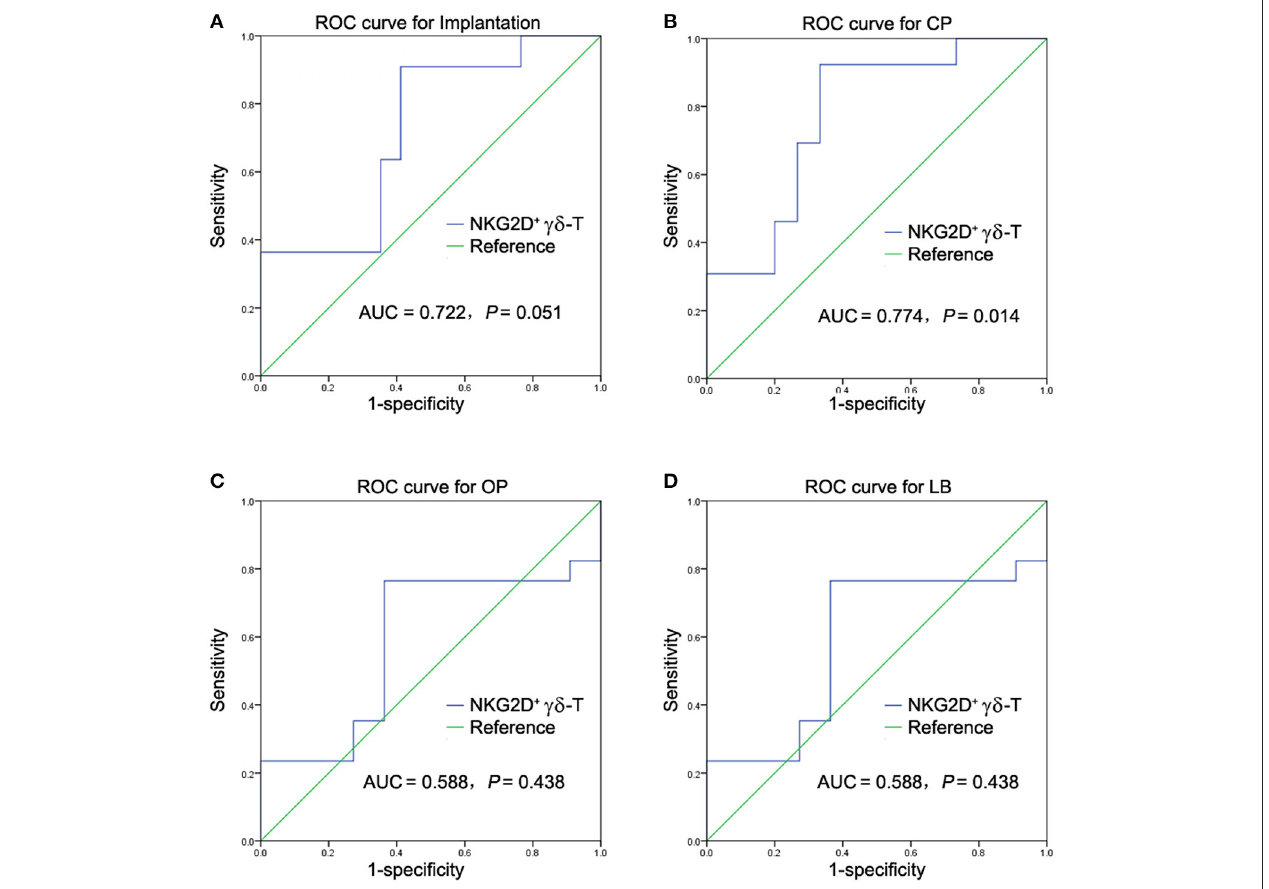
FIGURE 3 | ROC analysis of NKG2D + γδ -T cells in predicting pregnancy outcome failure in patients with uRIF. (A) Power analysis of NKG2D in predicting implantation outcome in patients with uRIF. (B) Power analysis of NKG2D in predicting clinical pregnancy outcome in patients with uRIF. (C) Power analysis of NKG2D in predicting ongoing pregnancy outcome in patients with uRIF. (D) Power analysis of NKG2D in predicting live birth outcome in patients with uRIF. AUC indicated the area of under curve of NKG2D + γδ -T cells, and P indicated the statistical power of NKG2D + γδ -T cells.